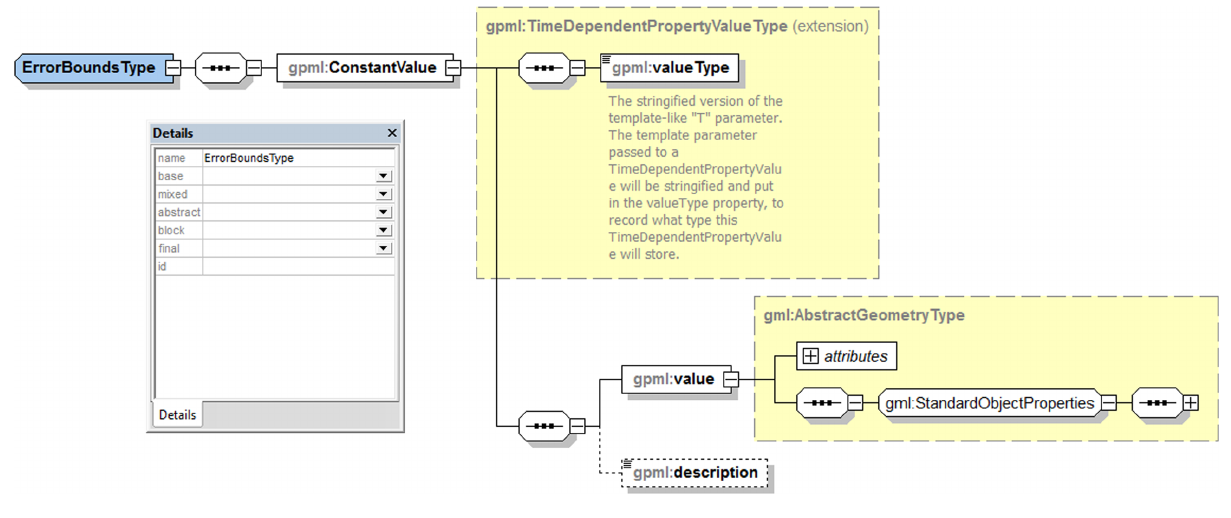
Fig. 18. The errorBounds geometry schema diagram in GPML.